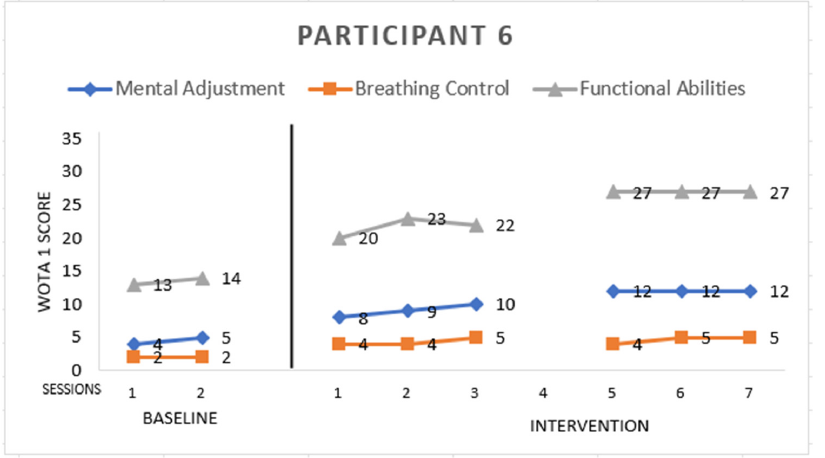
Figure 6. Highest possible scores: Mental Adjustment = 16, Breathing Control = 8, Functional Abilities = 36.